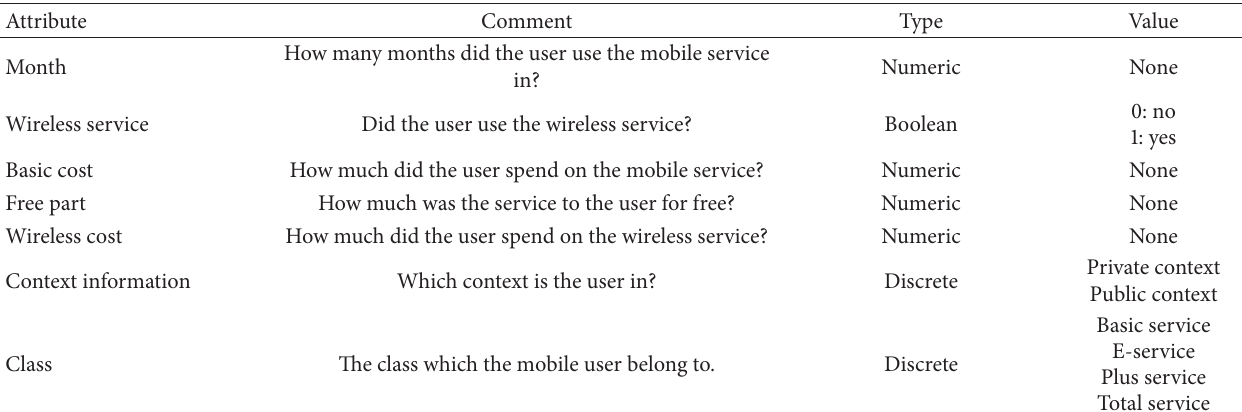
Table 1: Mobile user attributes information.